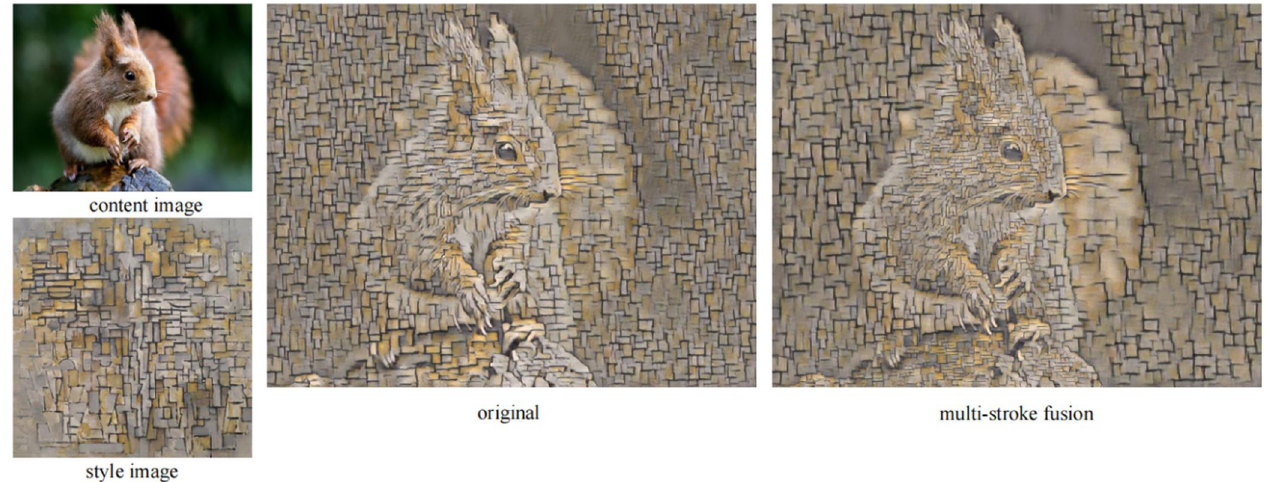
Fig 9. Comparison of the effects before and after the introduction of defocus adaptive multi-stroke feature fusion.